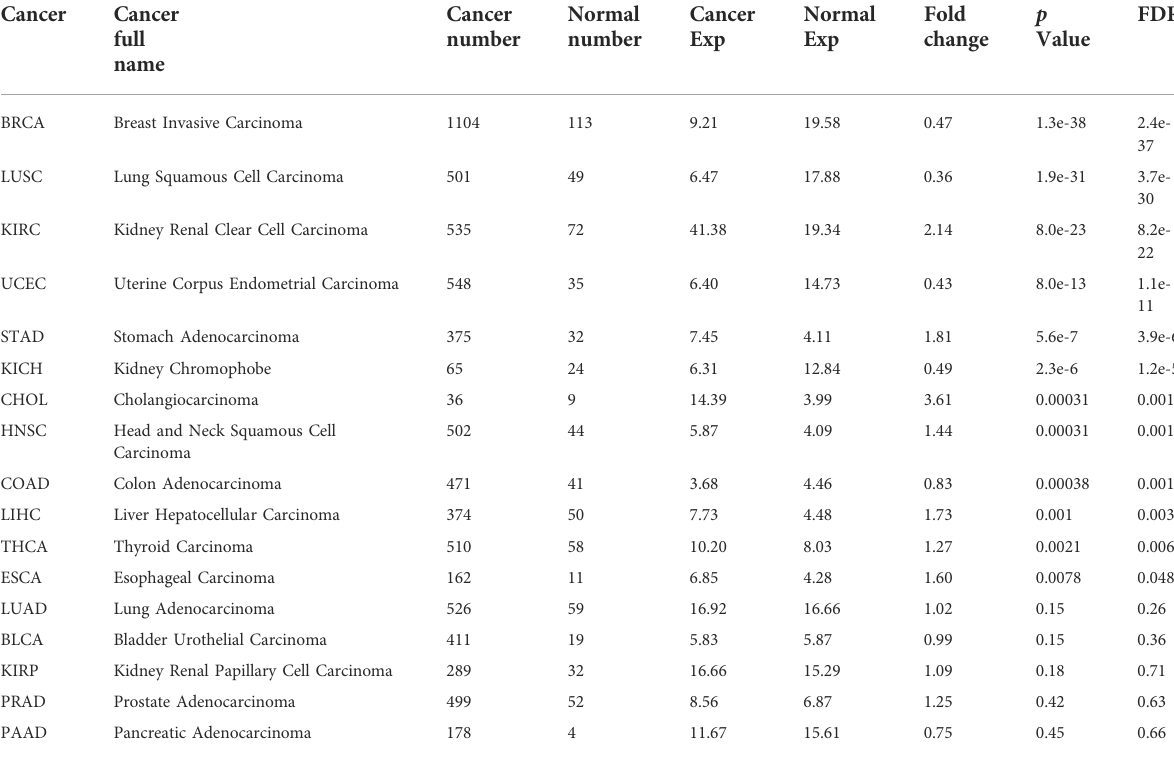
TABLE 1 The mRNA expression of NRP1 in different cancer types compared with normal tissues. Cancer Cancer full